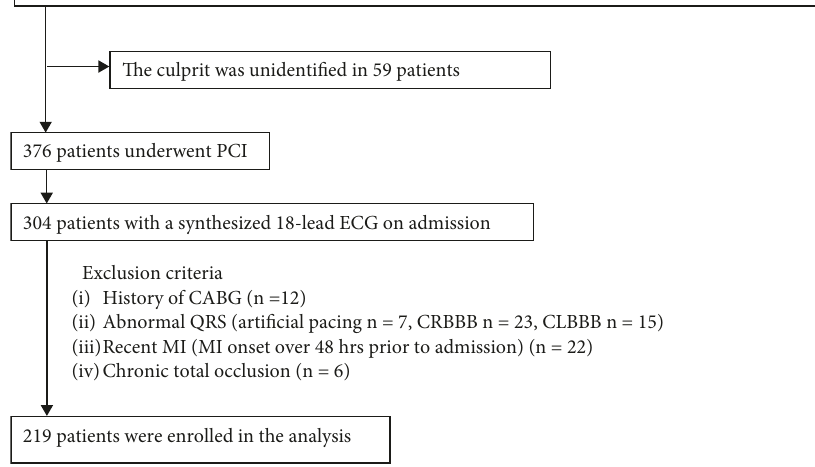
Figure 1: Study flow chart. 435 non-ST-segment elevation myocardial infarction (NSTEMI) patients were screened for eligibility. 376 patients underwent PCI. 304 patients had a recording of a synthesized 18-lead ECG on admission.85 patients were excluded according to the criteria. Finally, 219 patients were enrolled in the primary analysis. electrocardiogram, ECG; CRBBB, complete right branch bundle block; CLBBB, complete left branch bundle block; MI, myocardial